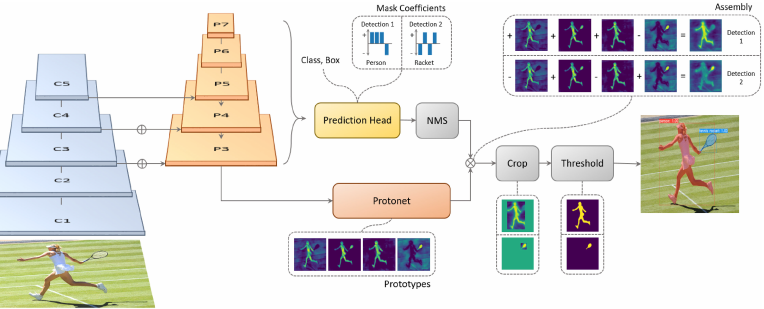
Figure 6. Yolact++ Architecture (Image reproduced from [21] with permission from the authors).